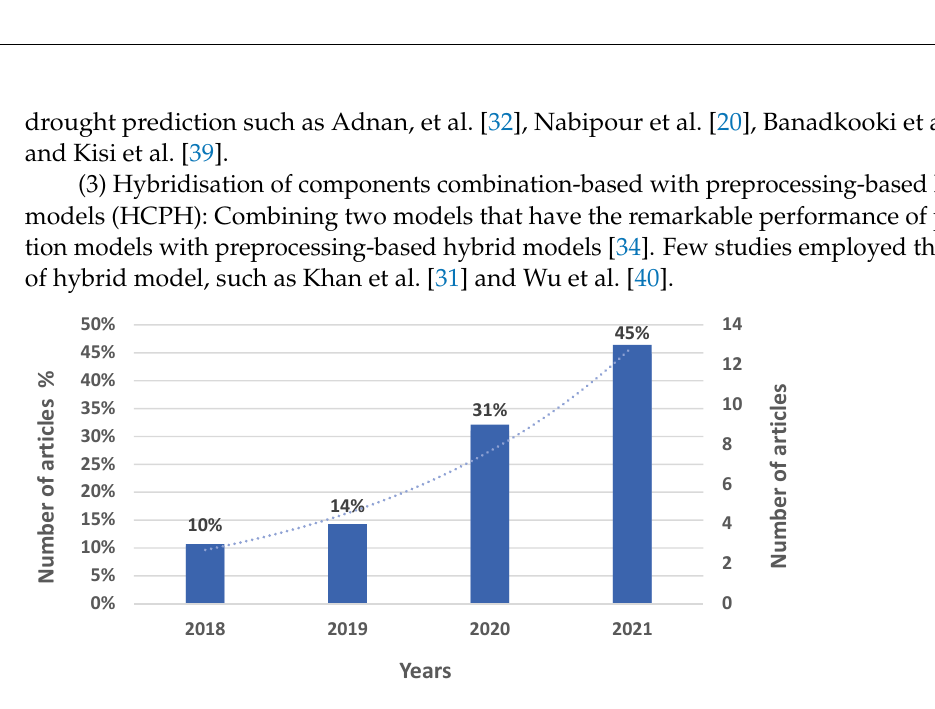
Figure 1. A percentage of studies on hybrid ML models used to predict drought indices over the last four years.